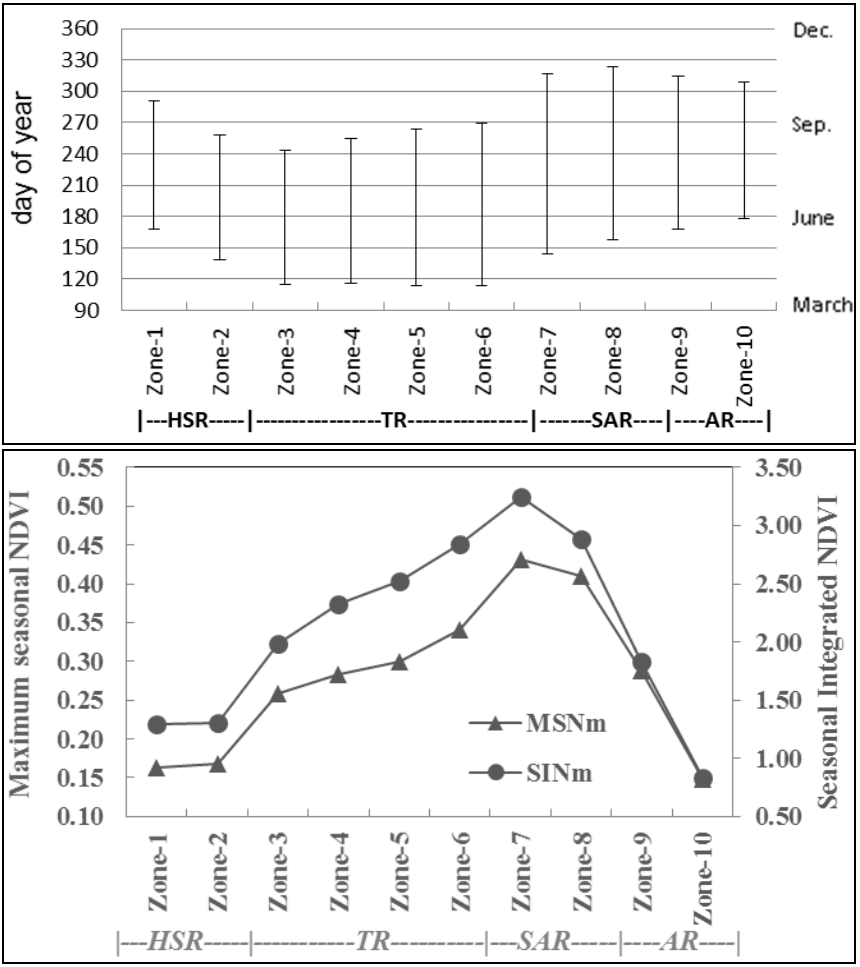
Figure 4. Grassland phenology across elevation zones averaged over 11 years. Bars indicate start, end, and length of growing season—Grassland productivity patterns across the elevation zones as indicated by Maximum seasonal NDVI and seasonally integrated NDVI averaged over 11